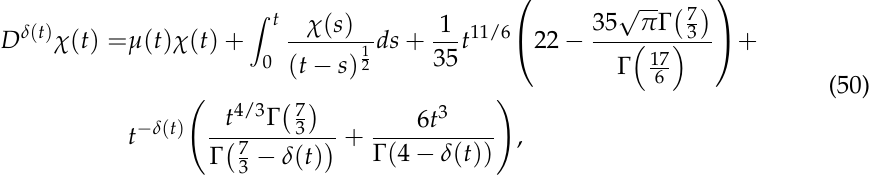
Figure 6. The approximate and exact solutions, χ N ( t ) and χ ( t ) , of Example 3 for N = 4, ( σ , ρ ) = ( 1 and λ = 1 2